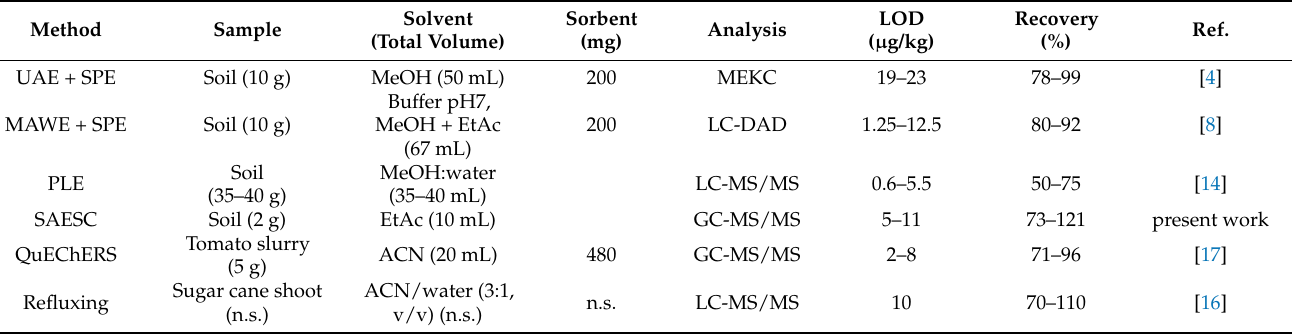
Table 3. Reported methods for the determination of metribuzin and their metabolites in soil and